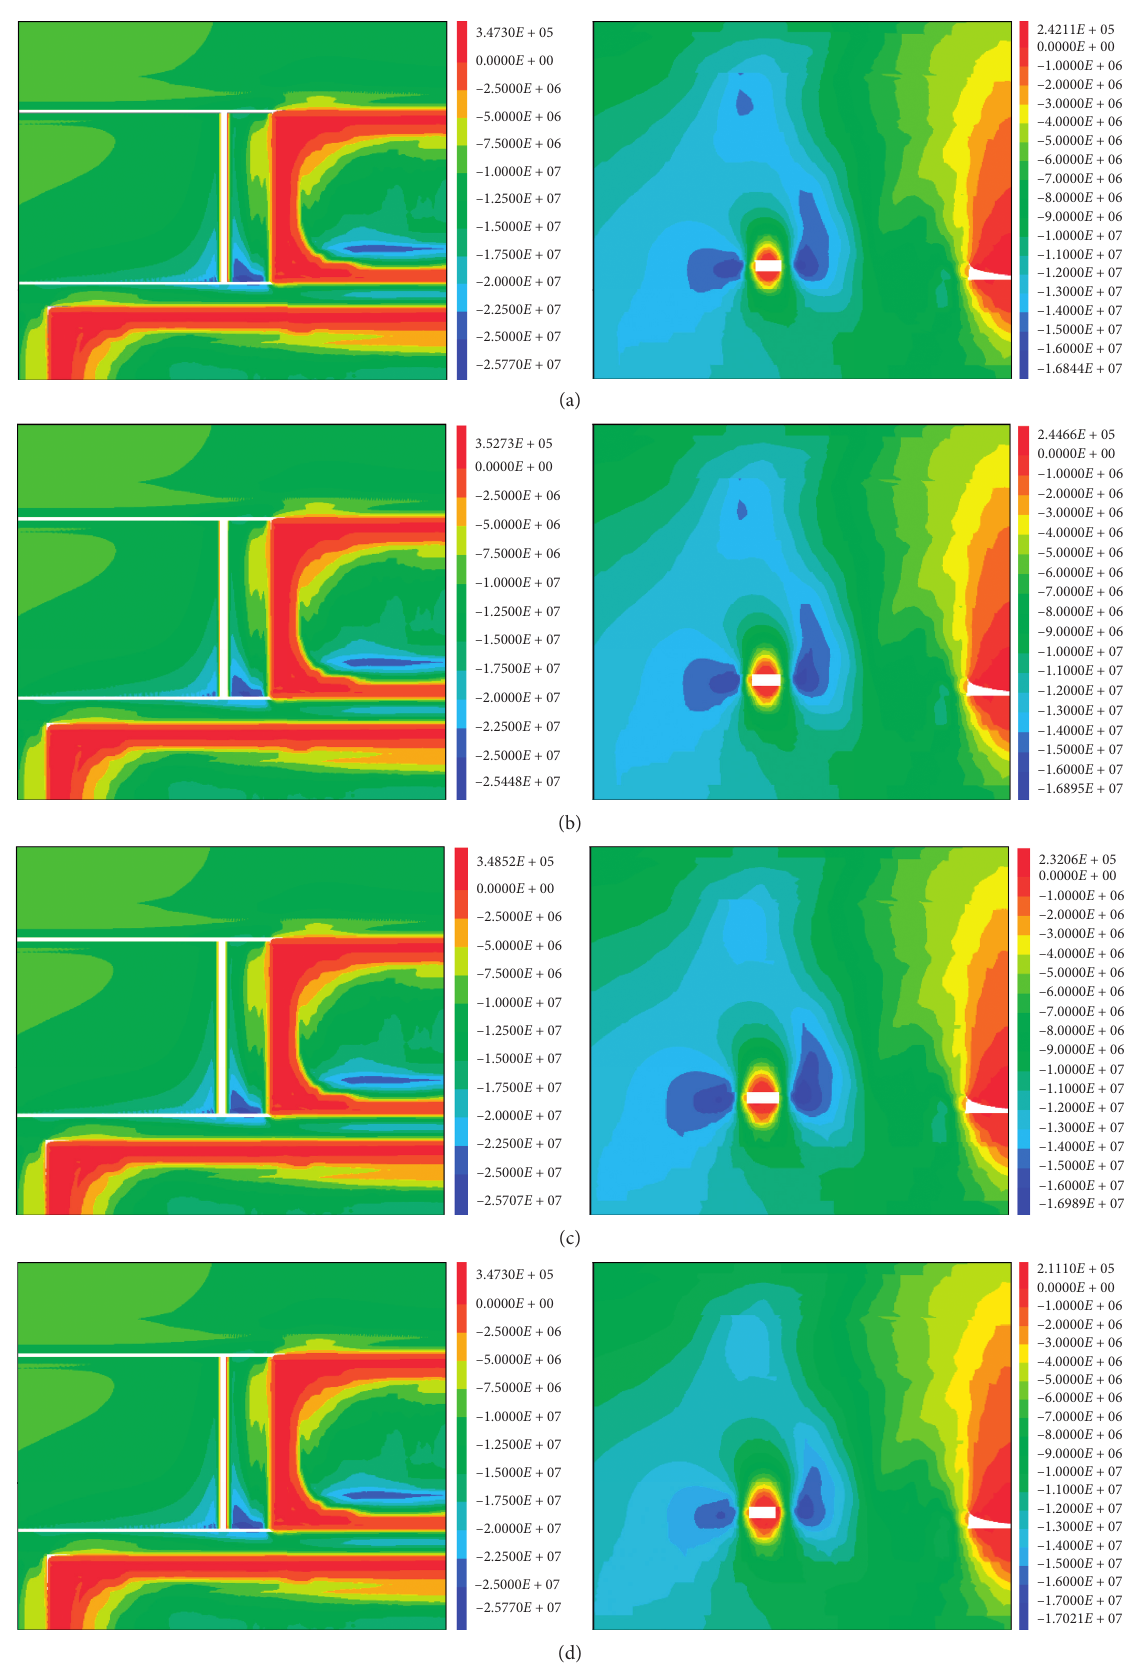
Figure 6: Nephogram of stress distribution in the initial mining stage of E1302 working face under a backfilling mining cycle. (a) Vertical stress distribution before cutting the first coal. (b) Vertical stress distribution before cutting the second coal. (c) Vertical stress distribution before backfilling. (d) Vertical stress distribution before the next coal cutting after